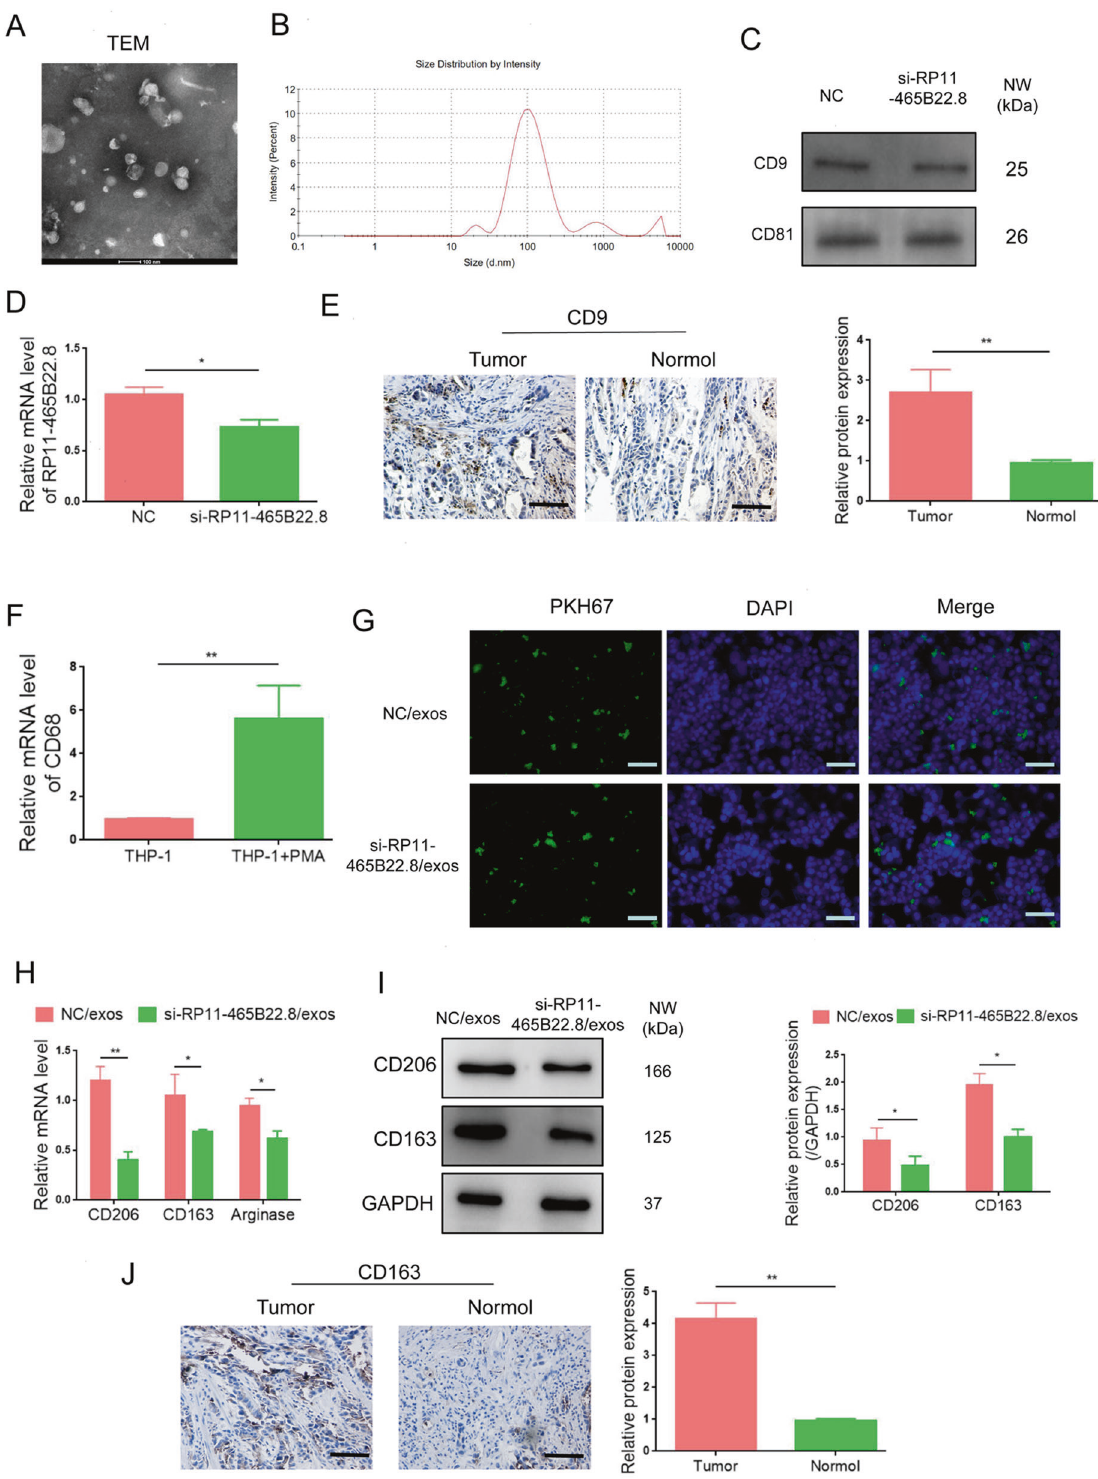
Fig. 6 Exosomal lncRNA RP11-465B22.8 promotes M2 polarization. A TEM analysis of isolated exosomes from KYSE-150 cells with lncRNA RP11-465B22.8 knockdown. B The size distribution of exosomes from KYSE-150 cells with lncRNA RP11-465B22.8 silencing. C Western blot analysis of the expression of CD9 and CD61 in exosomes from lncRNA RP11-465B22.8-silenced KYSE-150 cells. D qRT-PCR analysis of lncRNA RP11-465B22.8 in exosomes from KYSE-150 cells transfected with si-P11-465B22.8. E Immunochemistry staining of CD9 expression in EC tissues. F qRT-PCR analysis of CD68 in THP-1 cells with or without PMA treatment. G Immuno fl uorescence staining detecting the uptake of PKH67-labeled (green) exosomes by PMA-induced macrophages. DAPI was used to stain the nucleus. H qRT-PCR of the mRNA expression of CD206, CD163, and Arginase in PMA-treated THP-1 cells. I Western blot analysis of the protein expression of CD206, CD163 in PMA-treated THP-1 cells. J Immunochemistry staining of CD163 expression in EC tissues. * P < 0.05, ** P < 0.01.